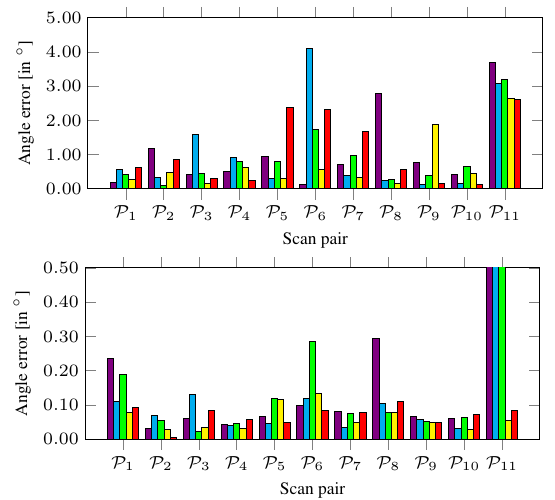
Figure 5. Average angle errors after the coarse registration (top) and after the fine registration (bottom) of scan pairs P j = {S j , S j +1 } : SIFT (violet), SURF (cyan), ORB (green), A-KAZE + M-SURF (yellow), SURF ∗ + BinBoost